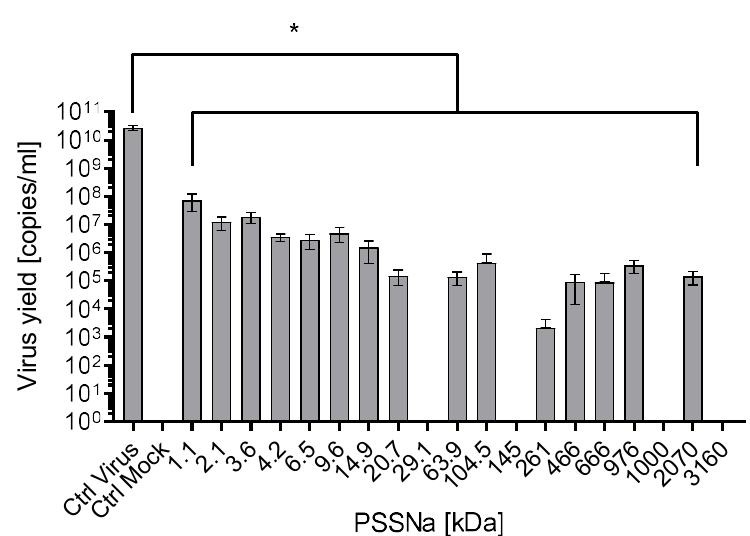
Figure 2. PSSNa inhibition of ZIKV replication correlates with the MW of the polymer. The assay was carried out in the U251 cells, infected with the ZIKV H/PF/2013 virus in the presence of different polymers at the concentration of 0.5 mg/mL. Inhibition of the infection was evaluated using RT-qPCR. Data are shown as virus yield (copies of viral genome per milliliter). All experiments were performed in triplicate. The results are presented as average values with standard deviations (error bars). An asterisk ( p < 0.05) indicates values that are significantly different from the control.